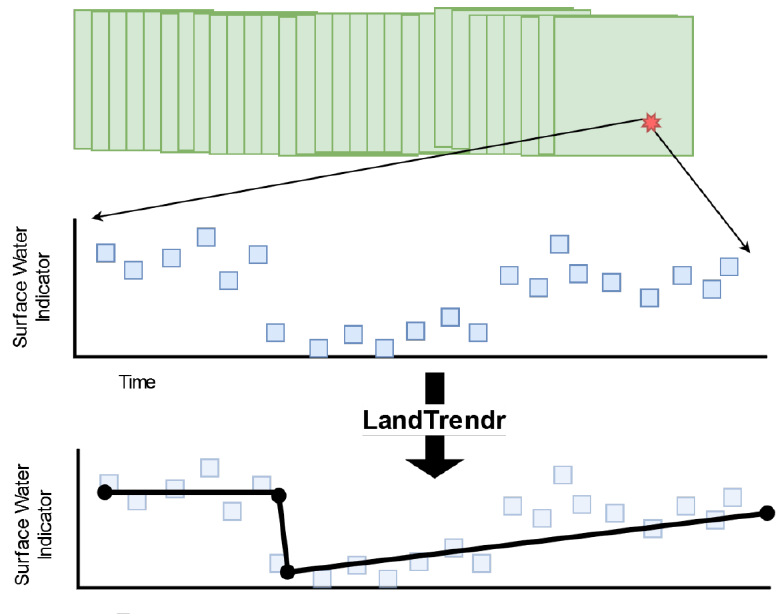
Figure 1. Conceptual diagram of the LandTrendr algorithm (adapted from Kennedy et al. [26,27,33]). Given a time series of surface reflectance information (represented in green), LandTrendr will segment the changes in pixel-values for a location over time (represented in blue). The result is a set of key inflection years and a linear regression between them (represented in black).